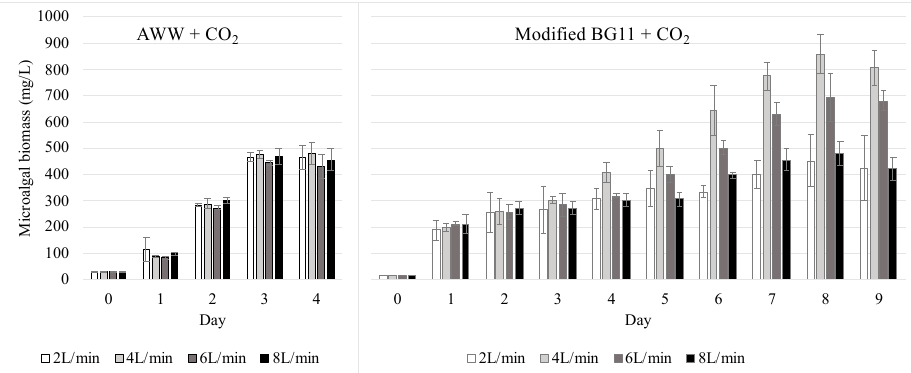
Figure 4. Growth curves and standard deviations of C. sorokiniana cultured in two different conditions: AWW + CO 2 = AWW and air-lifted with CO 2 -enriched air; BG11 + CO 2 = modified BG11 growth medium and air-lifted with CO 2 -enriched air. Four different flowrates were tested in each condition (2, 4, 6, and 8 L/min). Number of samples per treatment = 3.